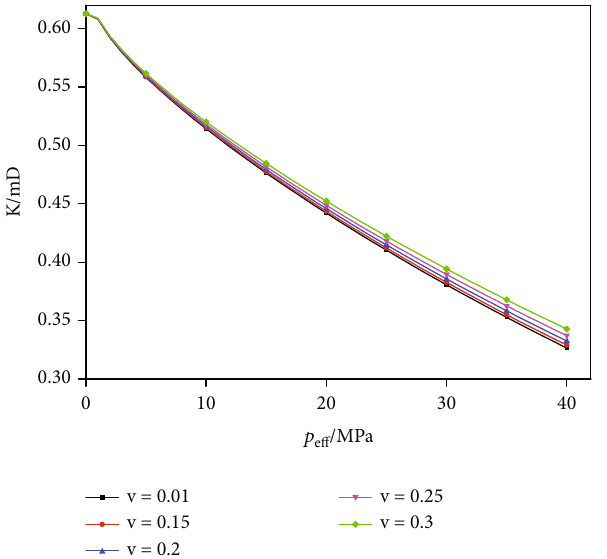
Figure 7: Relation curve between irreducible water saturation and e ff ective stress under di ff erent Poisson ’ s